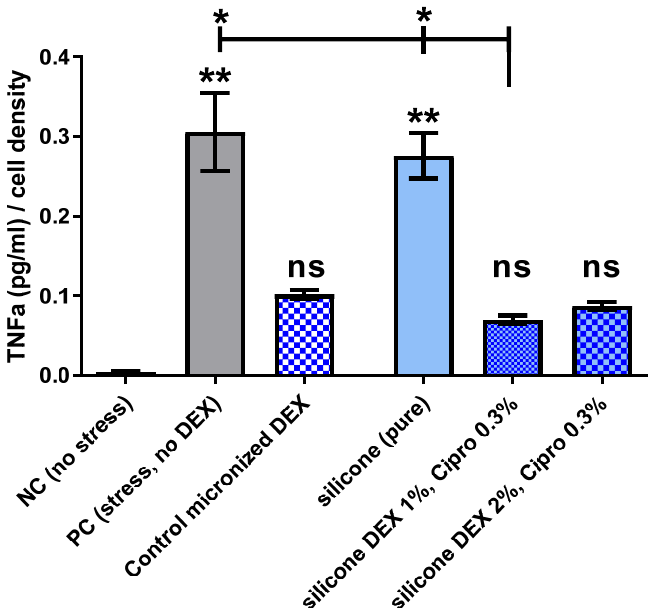
Figure 4. The ELISA-detected TNF α (tumor necrosis factor-alpha)-concentration normalized to the optical cell density in the dendritic cell culture of the different experimental groups is shown. Dif- ferences to the NC with basic TNF α -level of lipopolysaccharide (LPS)-unstressed cells are indicated above the bars. In the PC and for the pure silicone, the TNF α concentration was significantly in- creased compared to the NC, while the inclusion of DEX reduced the levels to an amount not dif- fering significantly from the NC. There was no difference detectable between the anti-inflammatory efficacy of DEX solution added to the medium or DEX released from the silicone into the eluates of the samples. The inclusion of 1% DEX (and 0.3% cipro) in the silicone reduced the TNF α -production induced by LPS stress significantly compared to the PC and pure silicone. This significant difference was not detected for 2% DEX-releasing samples or the DEX-control even though there was no dif- ference in TNF α reduction compared to 1% DEX-loaded samples. Data are given as the mean ± SD and significances are labeled with ** p < 0.001, * p < 0.05, ns: not significant. N = 1; n = 3 (NC, PC, silicone), n = 9 (silicone DEX 1%, cipro 0.3%, silicone DEX 2%, cipro 0.3%). To test for antibacterial activity of the DEX- and cipro-loaded UV–silicone, a stand- ardized bacteria-free areola test was performed. For both bacterial strains, S. aureus (Fig- ure 5a) and P. aeruginosa (Figure 5b), clear growth inhibition zones could be observed with silicone loaded with cipro and both 1% and 2% DEX. In contrast, no growth inhibition was detected for pure UV–silicone. The differences were statistically significant with p values from 0.006 t < 0.0001. Bacteria-free areolas were greatest for S. aureus with no dif- ference between 1% and 2% DEX loading. For P. aeruginosa , inhibition zones were in gen- eral smaller than for S. aureus . Furthermore, the diameter of the bacteria-free areola was significantly smaller for 1% DEX than for 2% DEX ( p = 0.03). Thus, silicone loaded with 1% DEX and 0.3% cipro exhibited the strongest antibacterial effect.